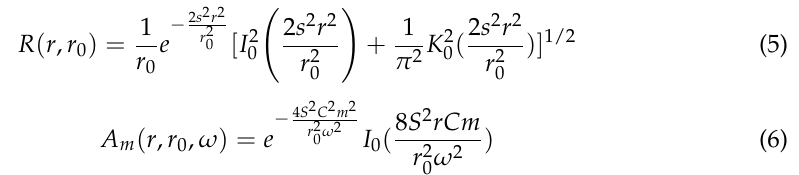
In Formula (3), S is the light scattering factor, C is the speed of sound in the bubble- containing liquid, β is the isothermal expansion coefficient, and C p is the specific heat at constant pressure, m is the order of higher harmonics, r is the radius of the photoacoustic cell, r 0 is the radius of the laser beam. The photoacoustic signal in the liquid photoacoustic cell is shown in Figure 5.